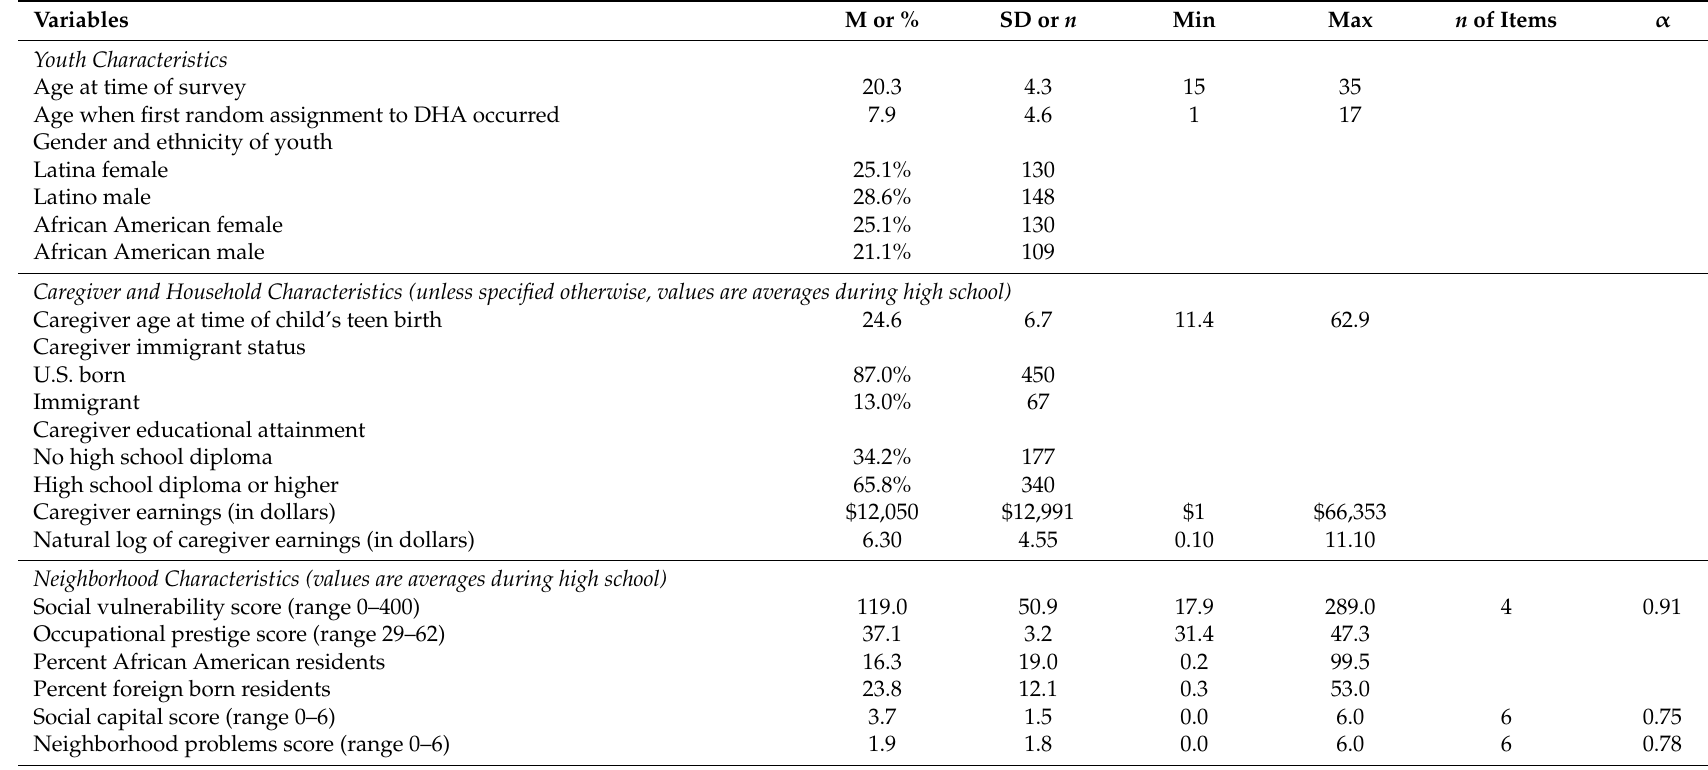
Table 1. Descriptive Characteristics of Youth, Caregivers, Households and Neighborhoods for Analysis Sample (N =